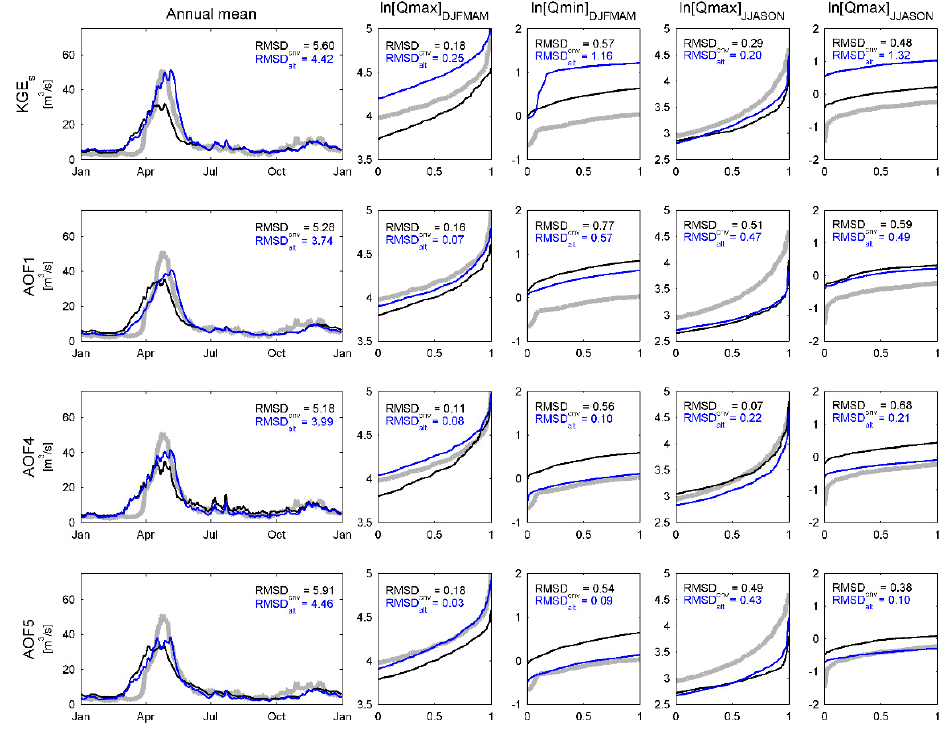
Figure 8. Observed (grey) and projected interannual hydrographs simulated by conventional (cvn, black) and alternative (alt, blue) configurations of the hydroclimatic modeling chain. The WaSiM-ETH hydrologic model is calibrated independently with KGE s , AOF1 , AOF4 , and AOF5 objective functions. Projections are also expressed through mean annual hydrographs and sorted logarithmic (ln) streamflow values below 10th and above 90th percentiles for both nival (DJFMAM) and pluvial (JJASON) seasons.